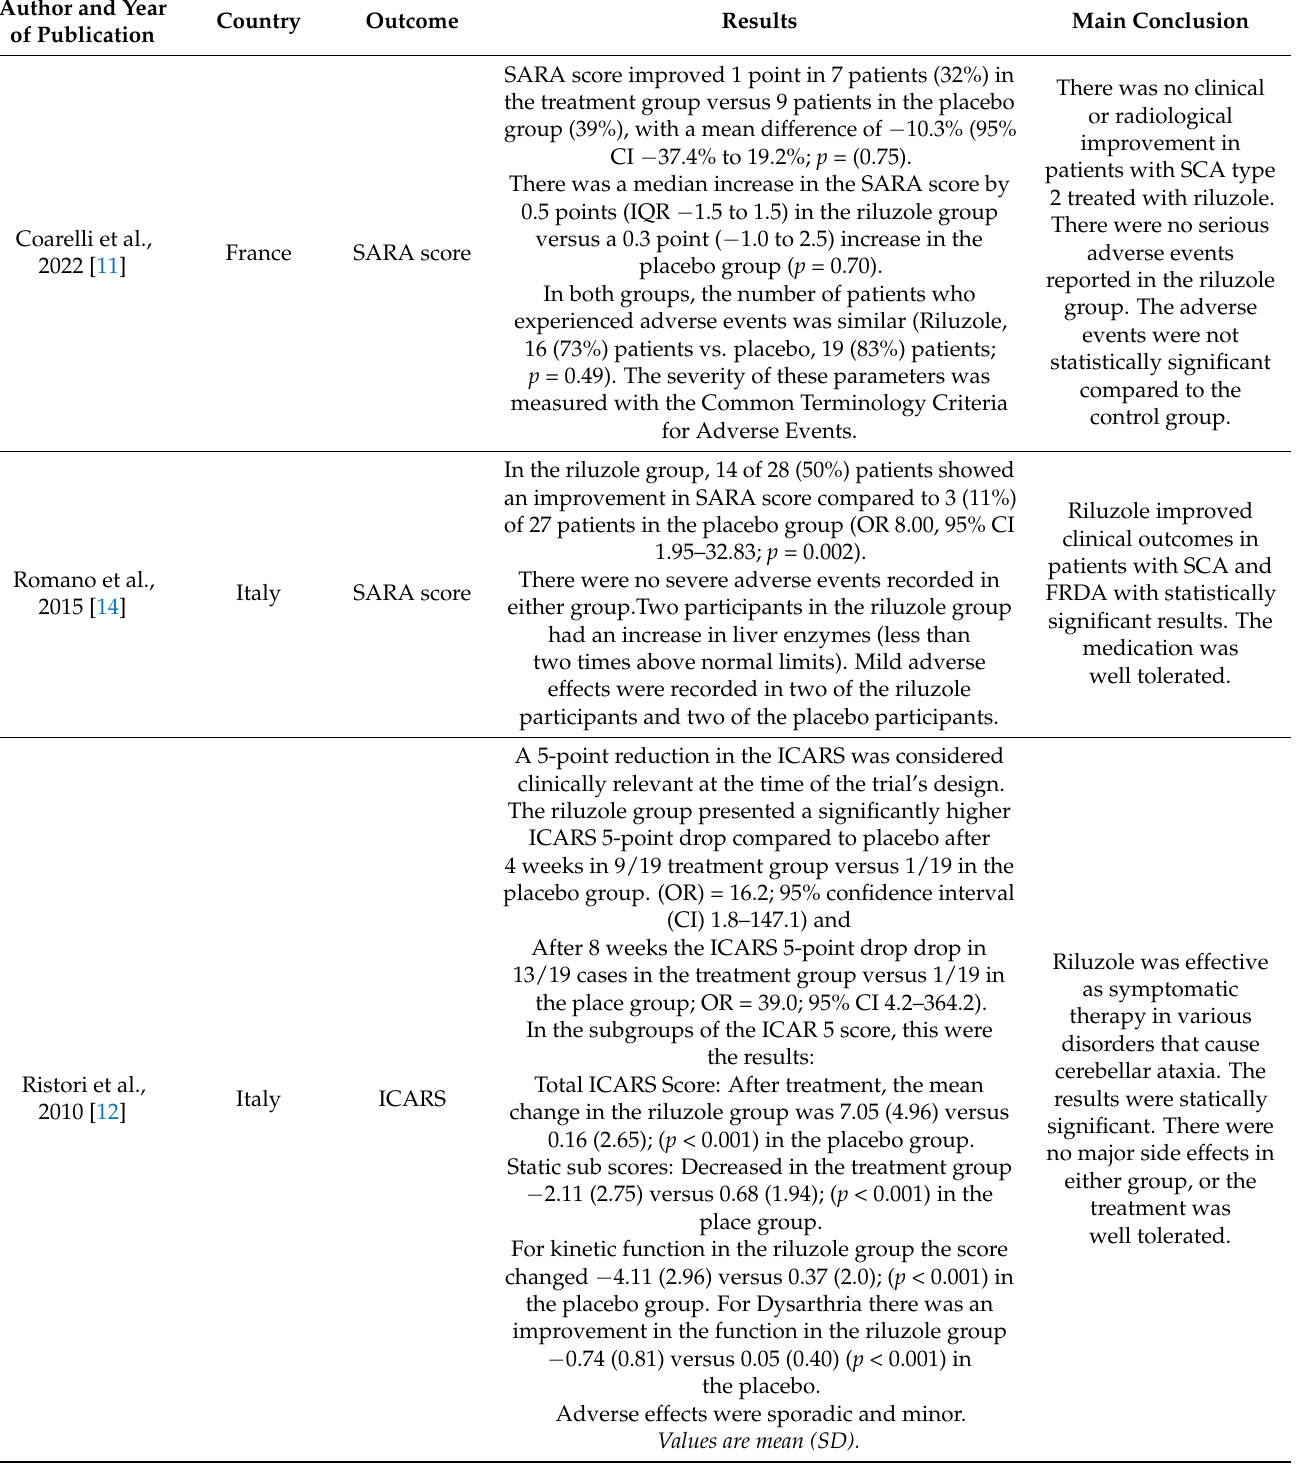
Table 3. The outcomes and conclusions of the clinical trials of this systematic